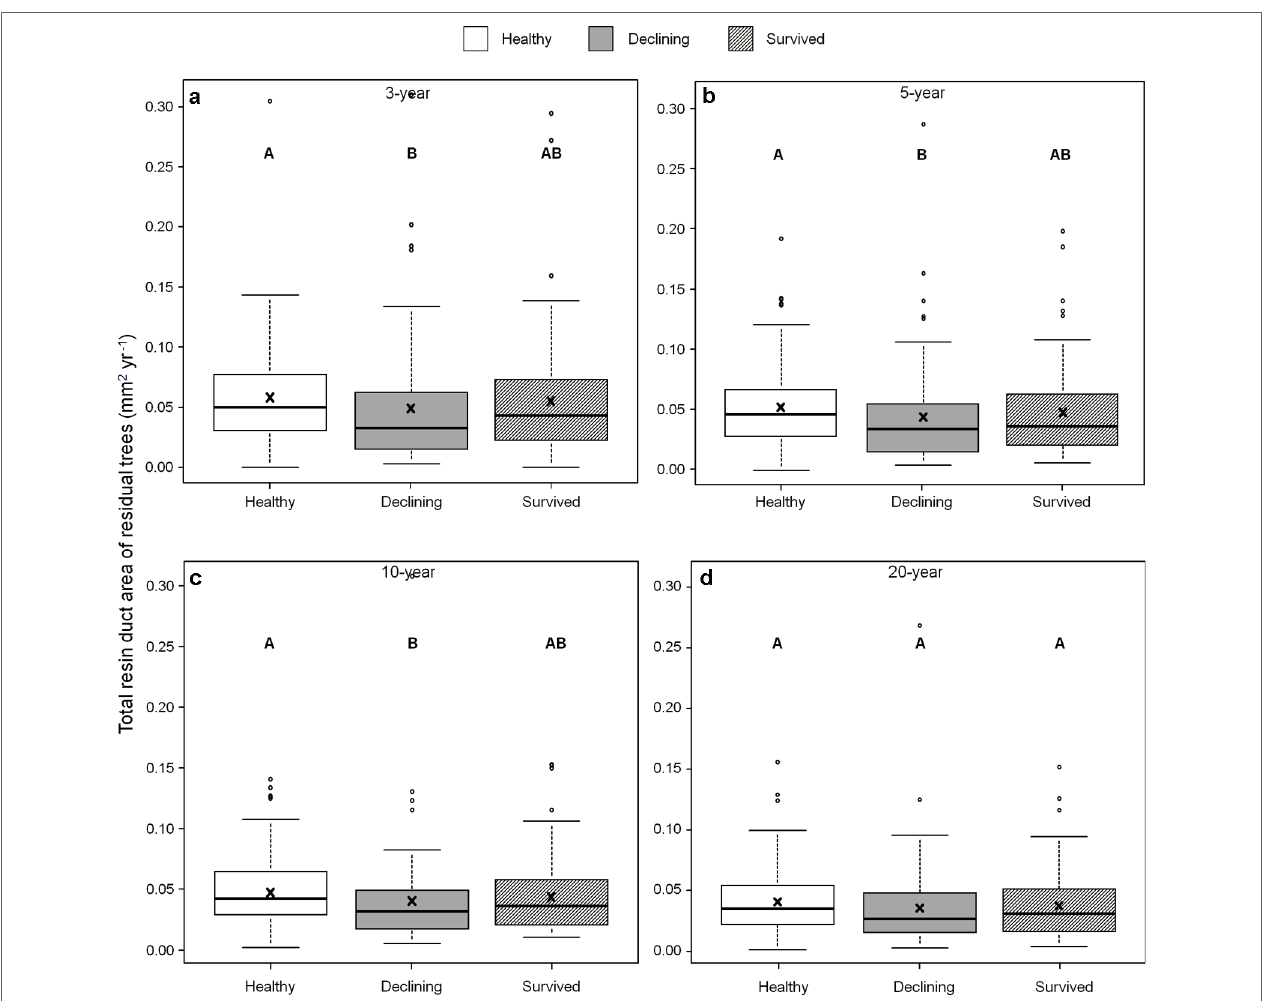
FIgURe 7 | Total resin duct area of three categories (healthy, declining, and survived) of residual Pinus contorta var. latifolia trees in four most recent growth periods (3 (a) , 5 (b) , 10 (c) , and 20 years (d) ). Significant differences among three tree categories were indicated by different letters based on the results of linear mixed-effects models (α = 0.05). In each box plot, the thick line is the median, × mark indicates the mean, the box represents the 1st and 3rd quartiles, whiskers are Tukey’s 1.5 interquartile range, and the open circles indicate outliers. Total resin duct area was log-transformed to stabilize the normality and homogeneity of variance of model